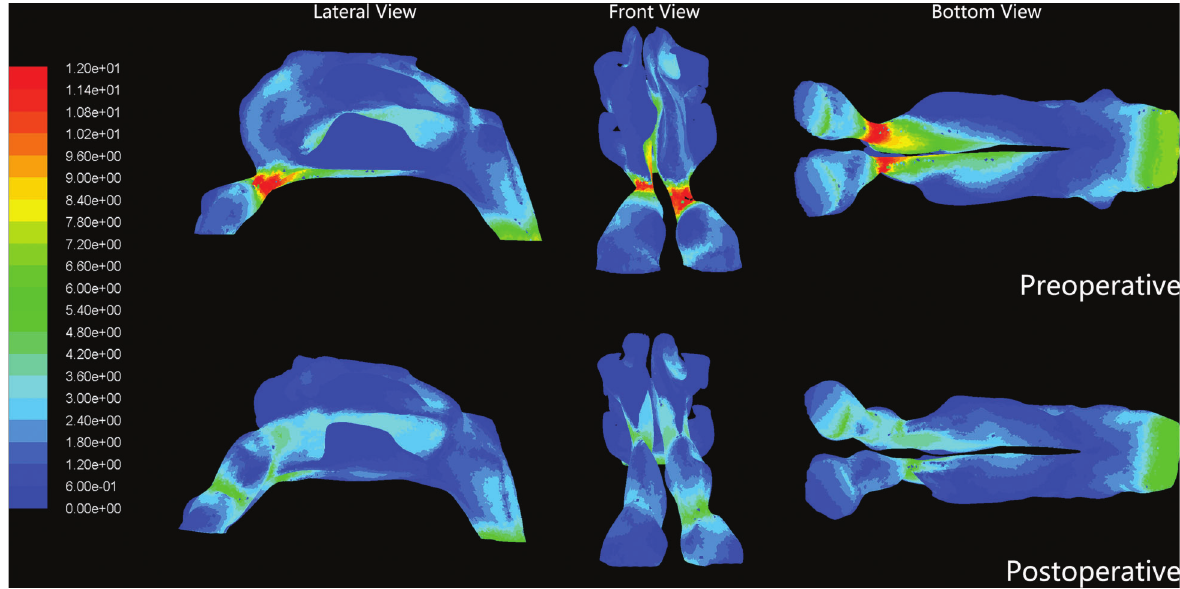
Figure 4. Pre- and postoperative air fl ow velocity distributions of the nasal cavity in one patient with anterior nasal cavity stenosis. Comparison of pre- and postoperative velocity distribution revealed that the largest velocity appeared in the nasal valve area. Red color indicates higher